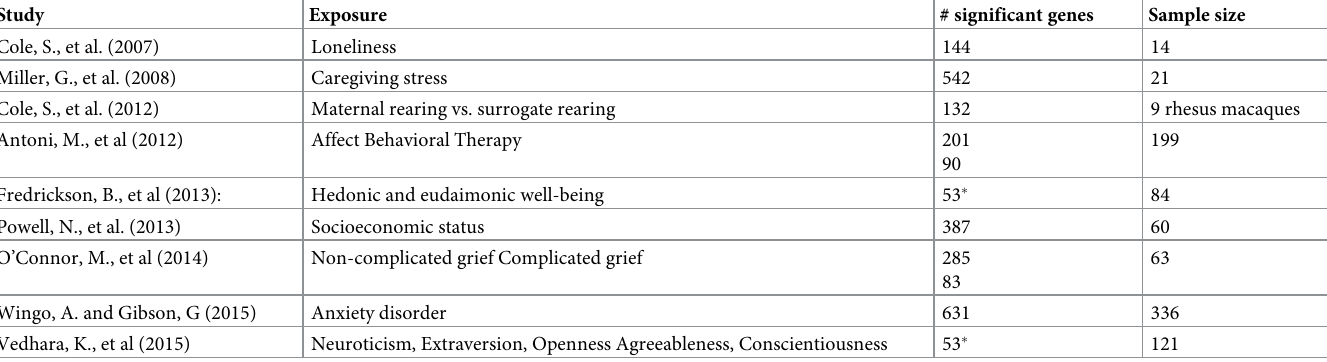
Table 1. Primary Studies of the conserved transcriptional response to adversity in